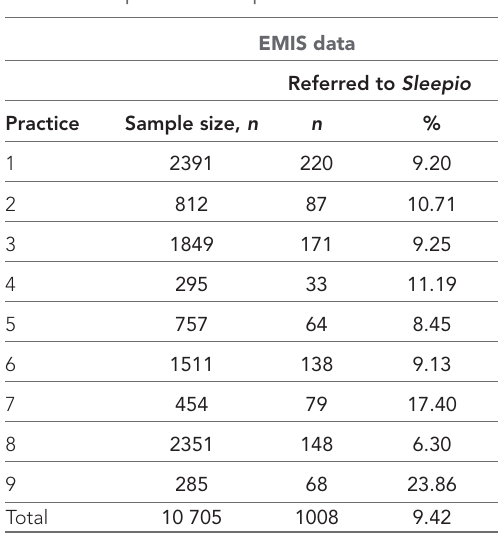
Table 2 GP practice